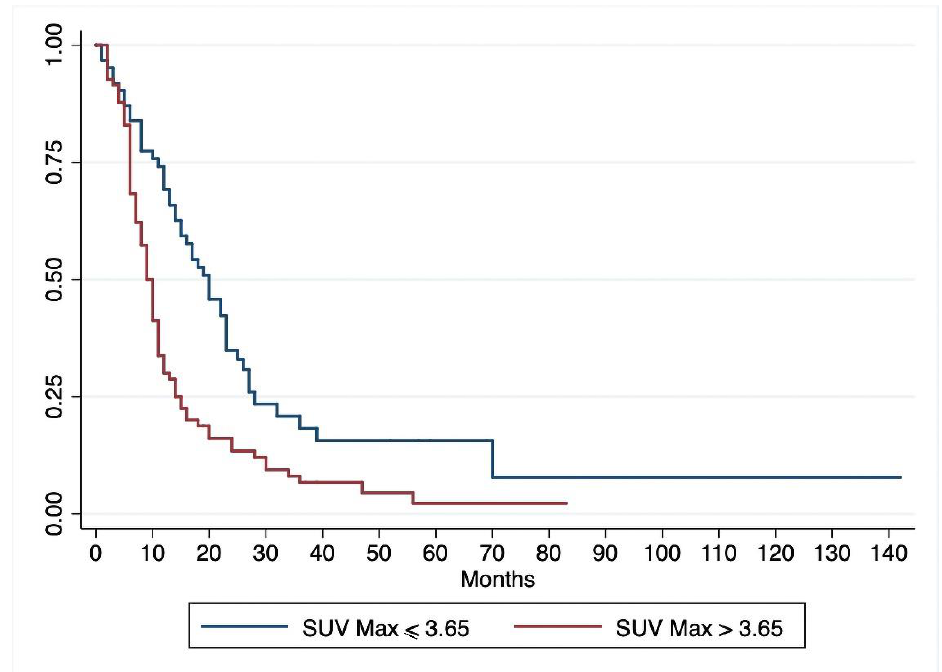
Figure 2. Kaplan–Meier curve for disease-free survival estimated for patients with preoperative SUVmax > 3.65 and those with SUVmax ≤ 3.65.